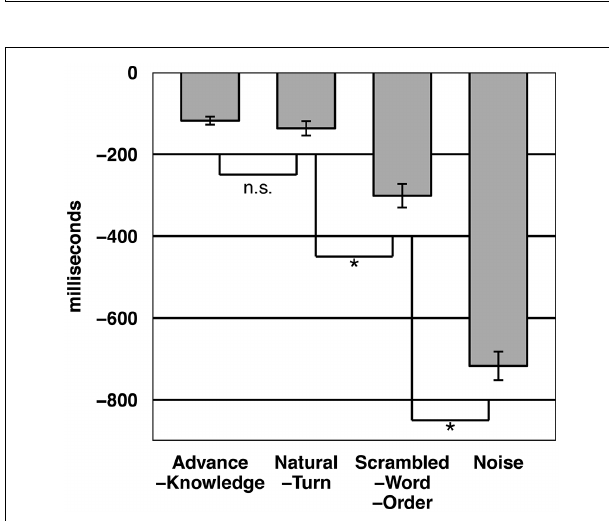
FIGURE 2 | Response distributions per condition from Experiment 1.